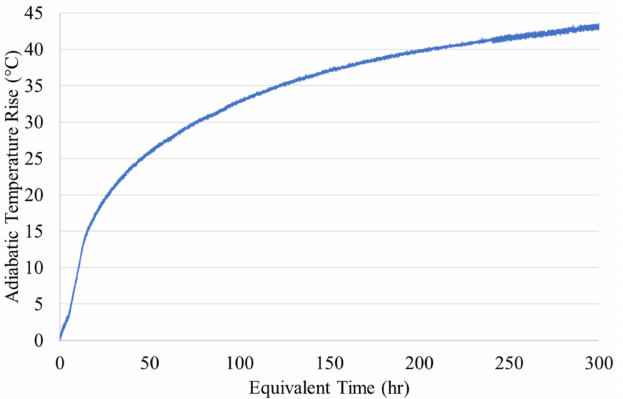
Figure 3. Adiabatic Temperature